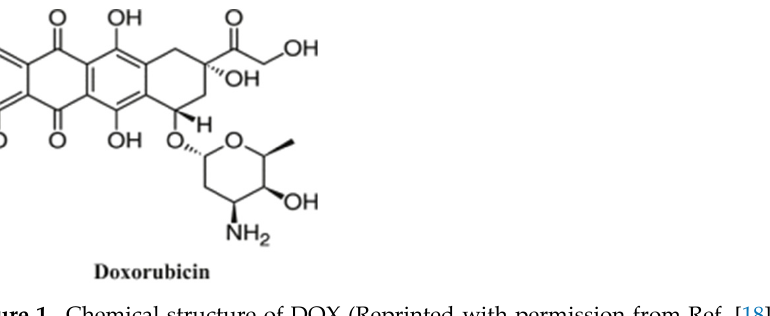
Figure 1. Chemical structure of DOX (Reprinted with permission from Ref. [18]. 2019, Gopalakrishna Pillai).